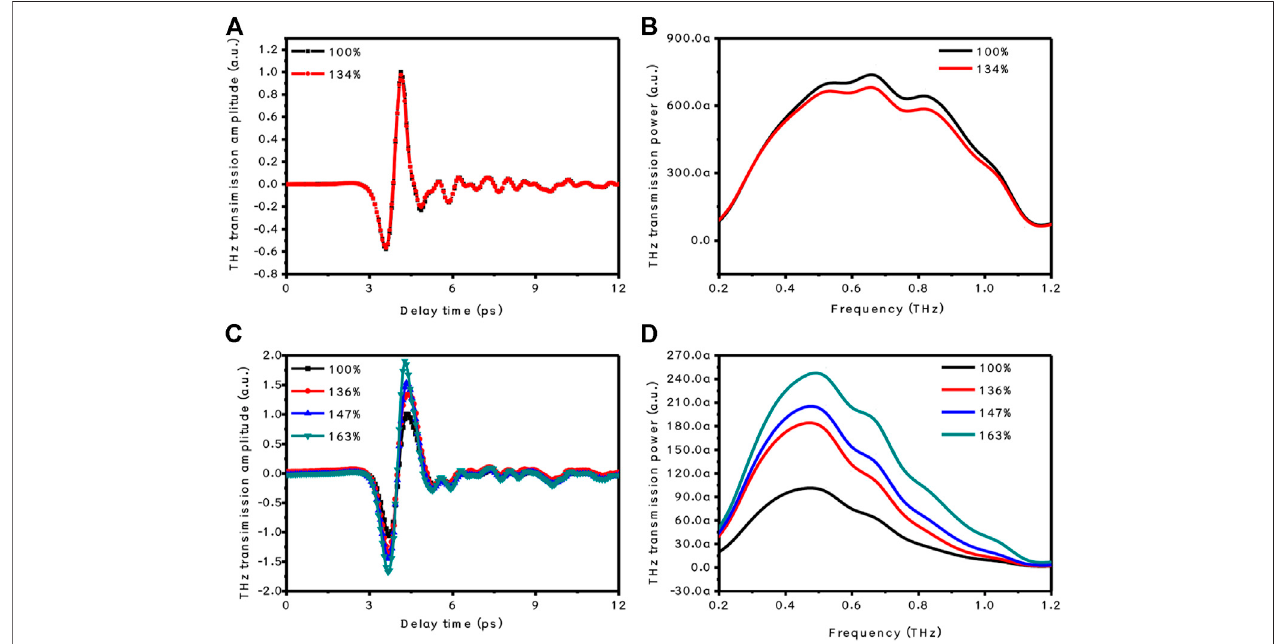
FIGURE 3 | (A) Terahertz time-domain spectra of samples without MXene coating on a PVAc substrate under tensile and non-tensile conditions. (B) Terahertz time-domain spectra of samples coated with MXene on PVAc substrate under different tensile degrees. (C) Terahertz frequency-domain spectra of samples without MXenecoating on PVAc substrate under tensile and non-tensileconditions. (D) Terahertz frequency-domain spectra ofsamplescoated with MXene on PVAc substrate under different tensile degrees.